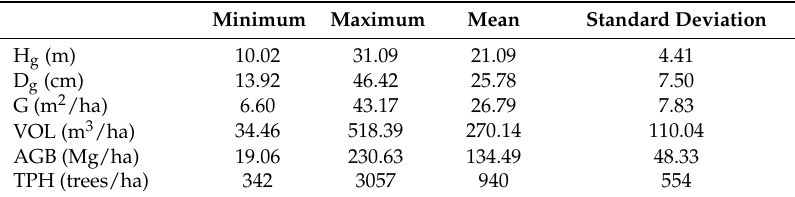
Figure 1. Study area, airborne laser scanning coverage, and sample plots. Table 1. The descriptive statistics of Lorey’s height (H g ), basal area weighted mean diameter (D g ), basal area (G), stem volume (VOL), aboveground biomass (AGB), and trees per hectare (TPH) in the 22 sample plots.